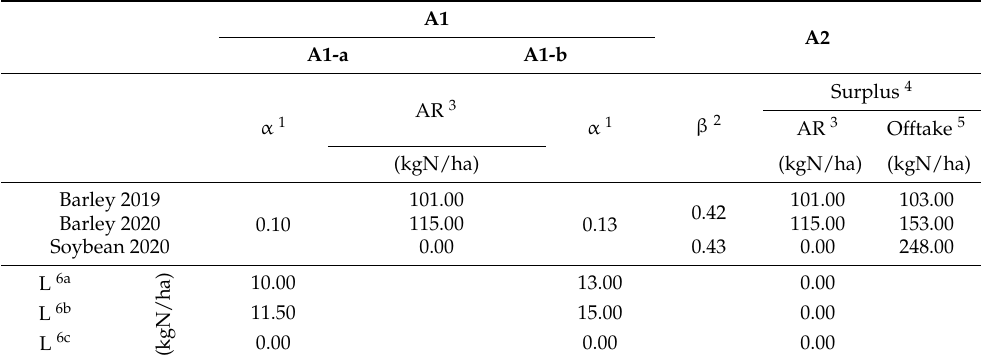
Table 2. Pollutant load (L) values obtained applying leaching/runoff fraction approaches (A1-a and A1-b) and surplus approach (A2) for barley and soybean crops in Tandil County, Buenos Aires province, Argentine Pampas Region, in 2019 and